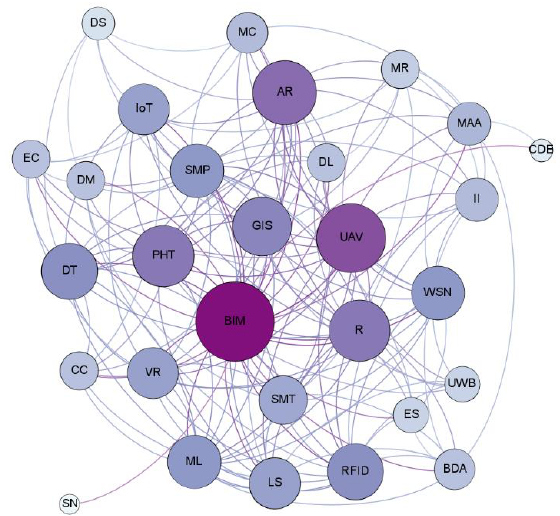
Figure 11. Full network analysis—closeness.